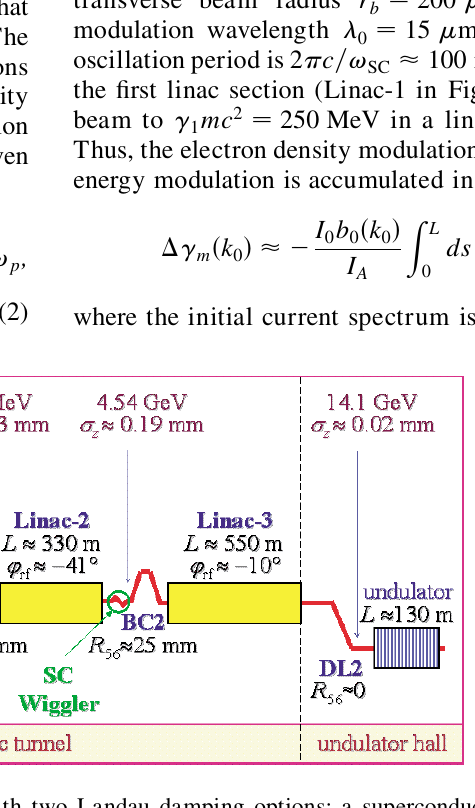
FIG. 1. (Color) Layout of the LCLS accelerator system with two Landau damping options: a superconducting (SC) wiggler at 4.5 GeVor a laser heater at 135